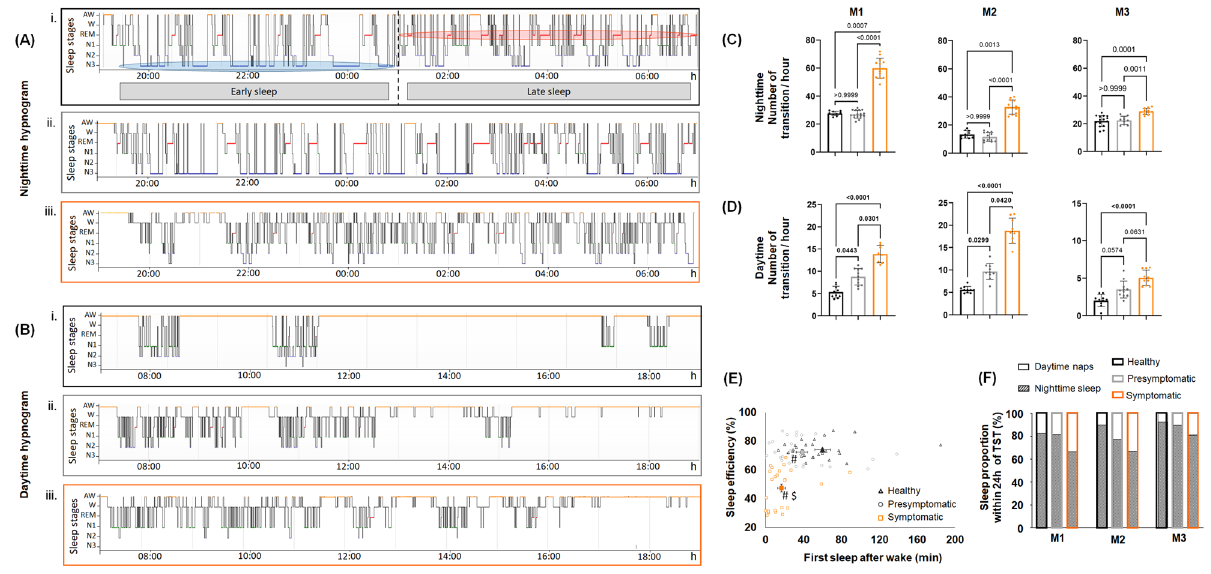
Figure 2. Nighttime and daytime sleep macro-architecture. ( A ) Nighttime hypnogramm (from M1), during healthy (i), presymptomatic (ii) and symptomatic (iii) states. The early sleep period is mostly composed by S3 (circled in blue) and the late sleep period is mostly composed by REM sleep (circled in red). Note the sleep fragmentation in symptomatic state where N3 and REM sleep are almost inexistent in early sleep and late sleep period respectively. ( B ) Daytime hypnogramm (from M1), during healthy (i), presymptomatic (ii) and symptomatic (iii) states. Note the naps disorganization since the presymptomatic state which is worse during symptomatic state. For both, ( A ) and ( B ) the line position indicates sleep/wake stages represented in y-axis. With A = active wake; W = quiet wake; N1, N2, N3 = non-REM sleep stage 1, 2 and 3; R = REM sleep. ( C ) and ( D ) Respectively nighttime and daytime number of transition between wake and sleep stages per hour for M1, M2 and M3, during healthy (black), presymptomatic (light grey) and symptomatic (orange) states. ( E ) Plot of nighttime sleep efficiency (%) according to the first sleep after wake (min) the following day, for all animals, during healthy, presymptomatic and symptomatic states. The mean and SEM are presented for each state. Kruskal–Wallis test followed by Dunn’s multiple comparisons test with # first sleep after wake different from healthy and $ sleep efficiency different from healthy. ( F ) Sleep proportion within 24 h of total sleep time expressed in percentage during daytime (white) and nighttime (hatched white), for M1, M2 and M3, during healthy (black), presymptomatic (light grey) and symptomatic (orange)